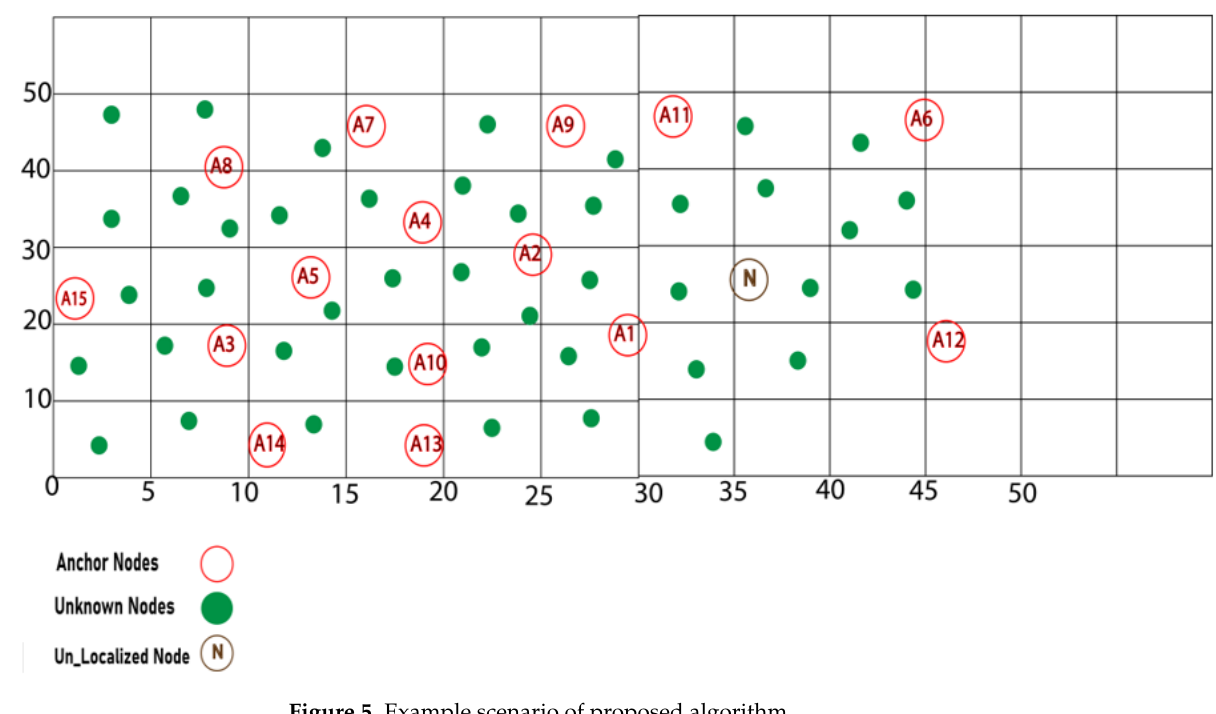
Figure 5. Example scenario of proposed algorithm. Table 1. Coordinates of anchor